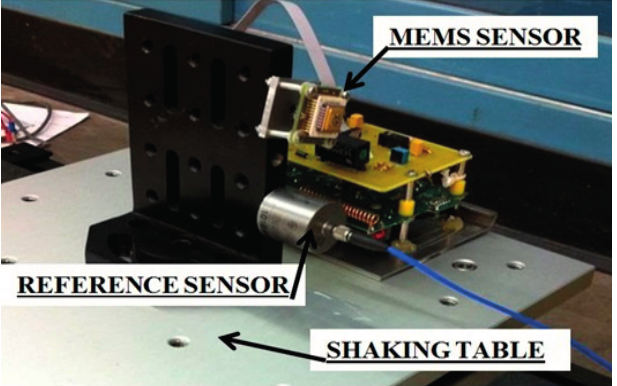
Figure 14. Setup for the shaking table test (sinusoidal wave input).